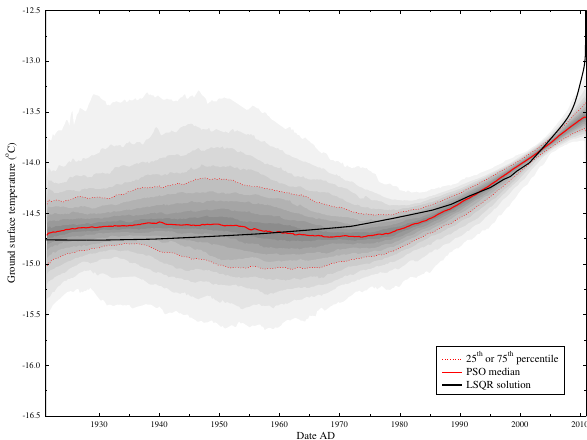
Fig. 6. Reconstructed ground surface temperature history using PSO optimisation with a RMS threshold of 0.05 ◦ C (red) and LSQR solution (black). The shading increments in 5% percentiles of the PSO distribution. Fig. 7. The temperature profile down the Mill Island borehole by the forward model for the LSQR and median PSO surface temperature reconstructions.